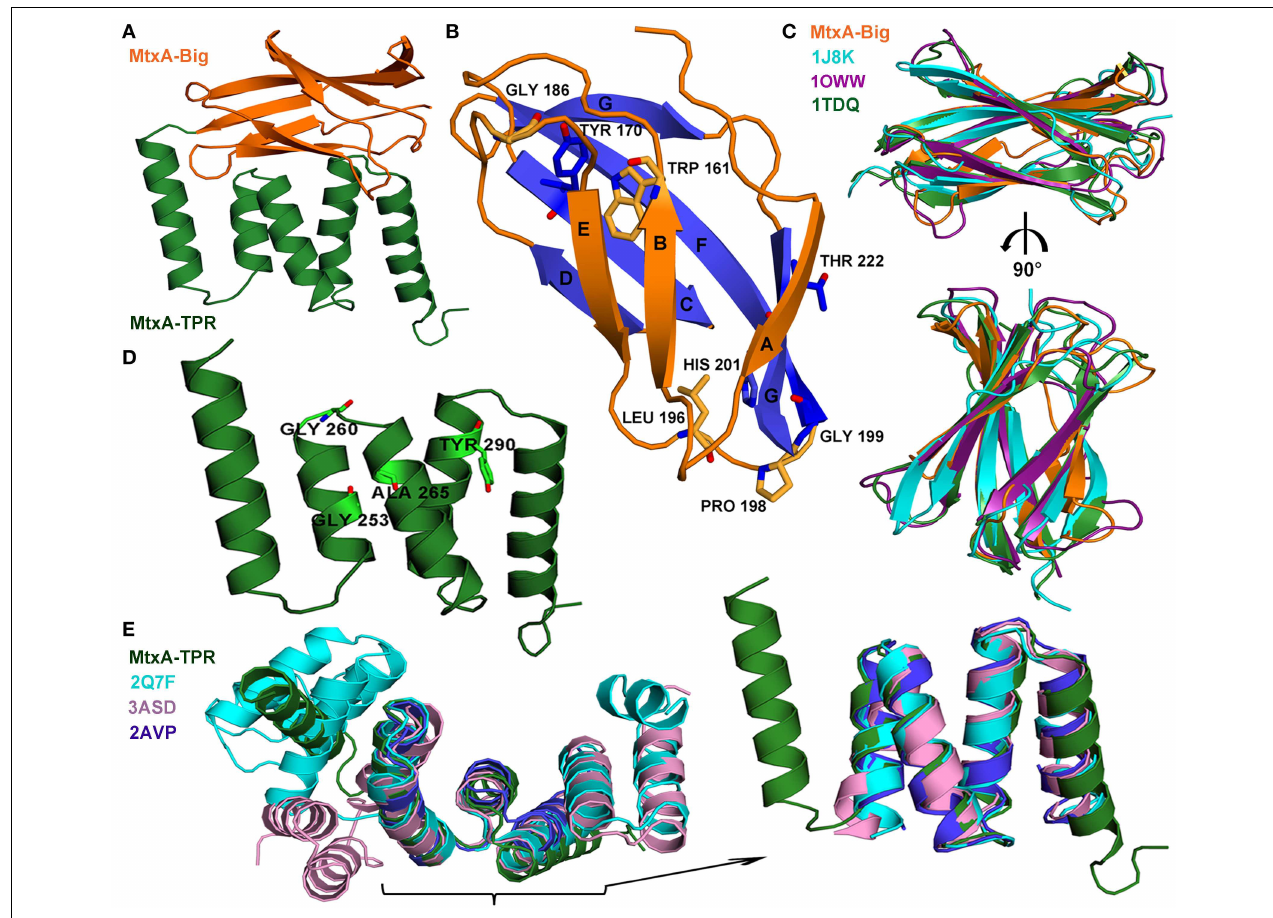
FIGURE 3 | MtxA 1 1 − 141 crystal packing and overall structures. (A) The representative crystal packing of MtxA 1 1 − 141 structure contains a two-domain architecture: MtxA 142 − 226 (MtxA-Big) and MtxA 227 − 313 (MtxA-TPR) motifs. (B) The overall β -sandwich fold of the MtxA-Big structure; the seven β -sheets are labeled (A–F). The conserved amino acids are in stick representation. (C) Superimposition overlay of MtxA-Big with three of the Dali server’s alignments in cartoon representation reveals the high structural similarity: MtxA-Big in orange, 1J8K in cyan, 1OWW in deep purple and